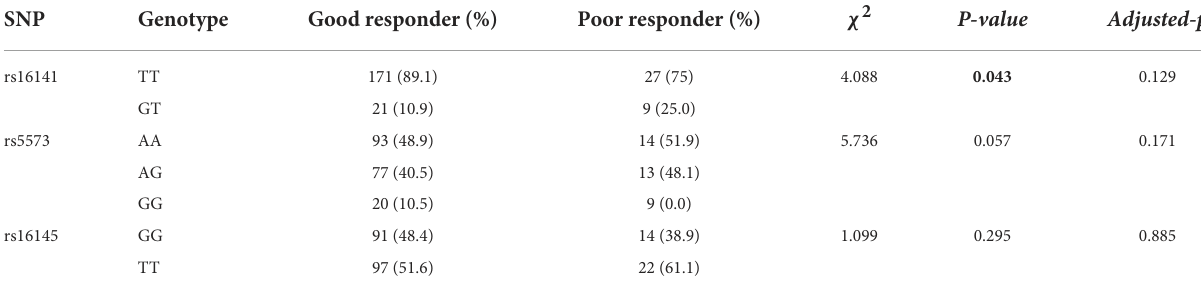
TABLE 3 Comparison of SNPs genotype distribution in two groups.